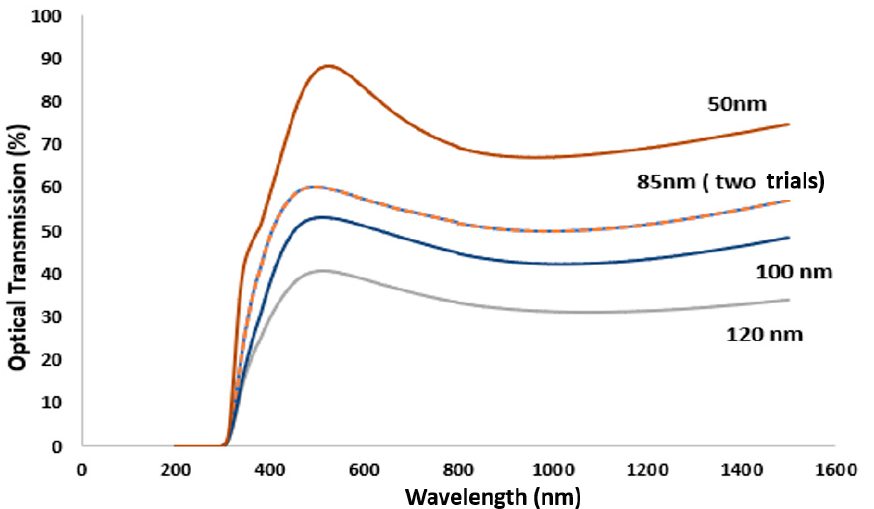
Figure 3. Transmission spectra of TiN films deposited onto a clear glass substrate, using 350 watts RF power to the Ti target under 2 mT pressure with the Ar (10 sccm) and N 2 (2 sccm) gas flow.